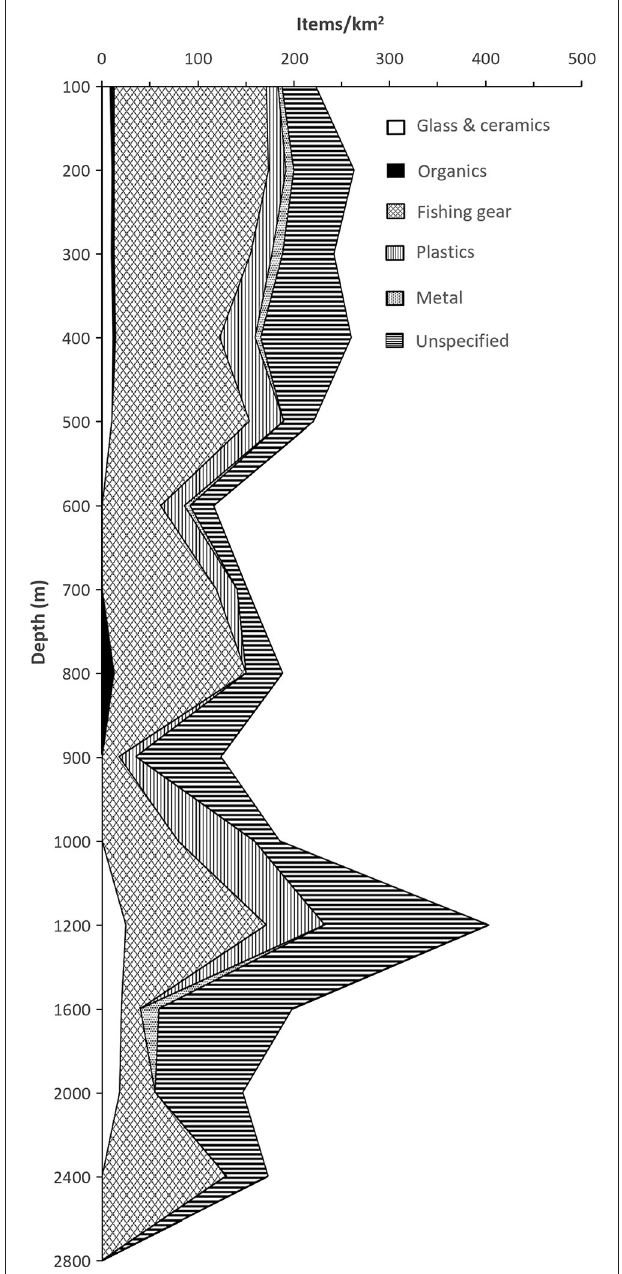
FIGURE 4 | Average abundance of litter vs.